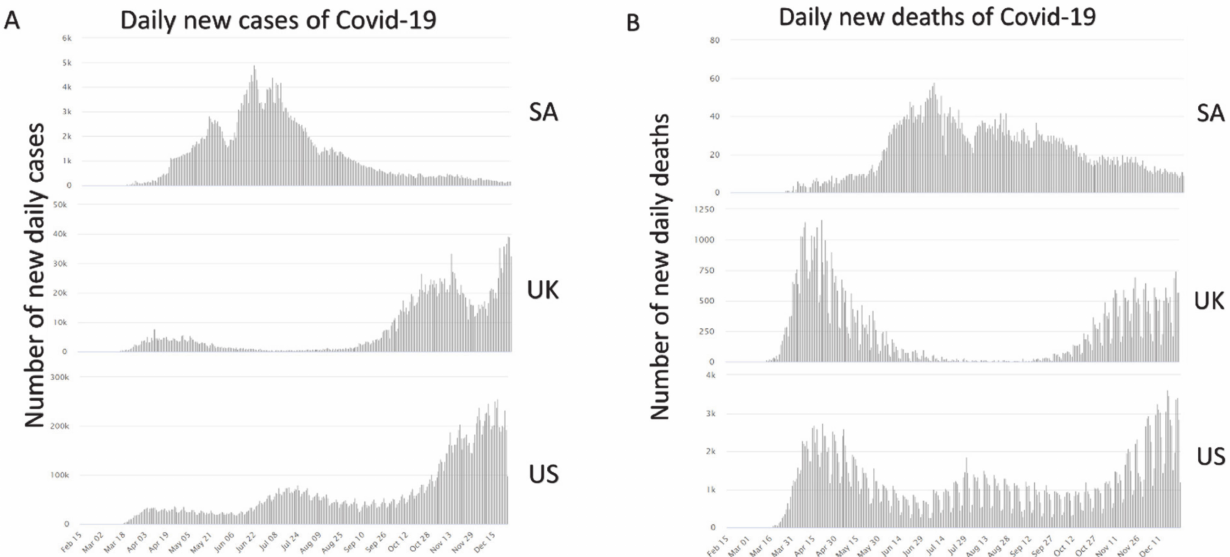
Figure 2. Daily new cases and deaths of Covid-19 in Saudi Arabia in comparison to UK and US. ( A ) The 3 graphs demonstrate the number of daily new cases in SA compared to UK and US. The peak number of new daily cases in SA is significantly less than UK and US. Such difference can be appreciated by the vast difference in the labeling of the Y axis. Similarly, ( B ) the peak number of daily deaths of Covid-19 infections in SA was significantly less than the UK’s and the US’s. Figures were retrieved from the Worldometers Covid-19 portal [7]. SA: Saudi Arabia; UK: United Kingdom; US: United